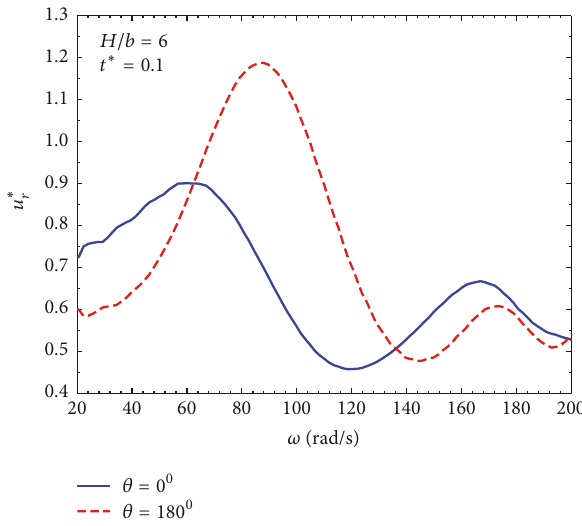
Figure 6: Radial displacement (𝑢 ∗ 𝑟 ) versus frequency at 𝑟 = 𝑏 for 𝜃 = 0 ∘ and 𝜃 = 180 ∘ for a tunnel in hard soil.